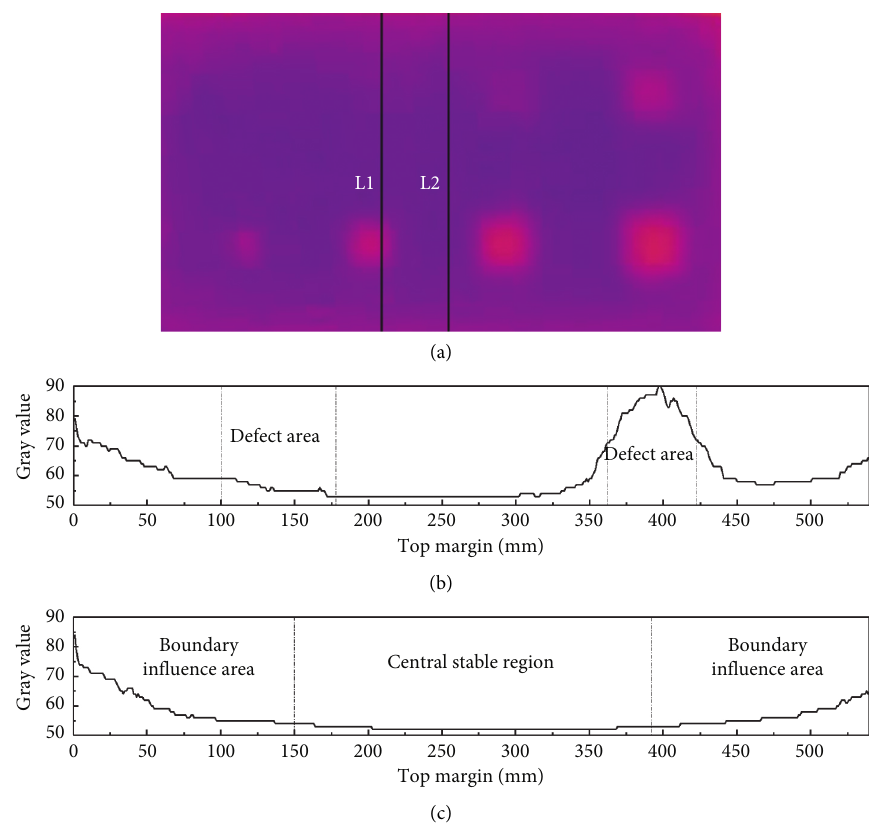
Figure 7: Line layout and gray level. (a) Line layout. (b) L1-gray level. (c) L2-gray